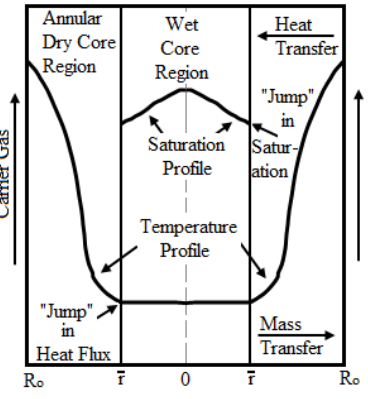
Figure 36. Scheme of coal block models (modified from Perkins and Sahajwalla [76]).